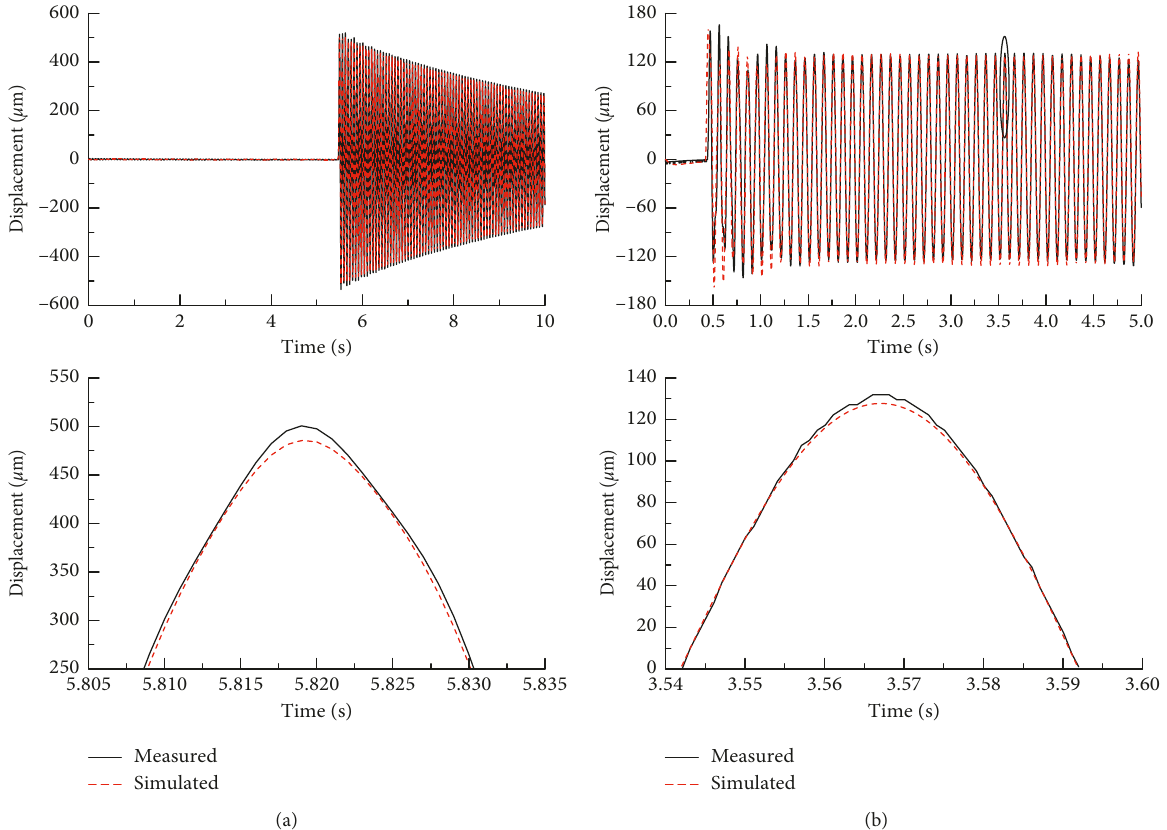
Figure 11: Comparisons of the simulation result with the experimental result: (a) impact load and (b) harmonic